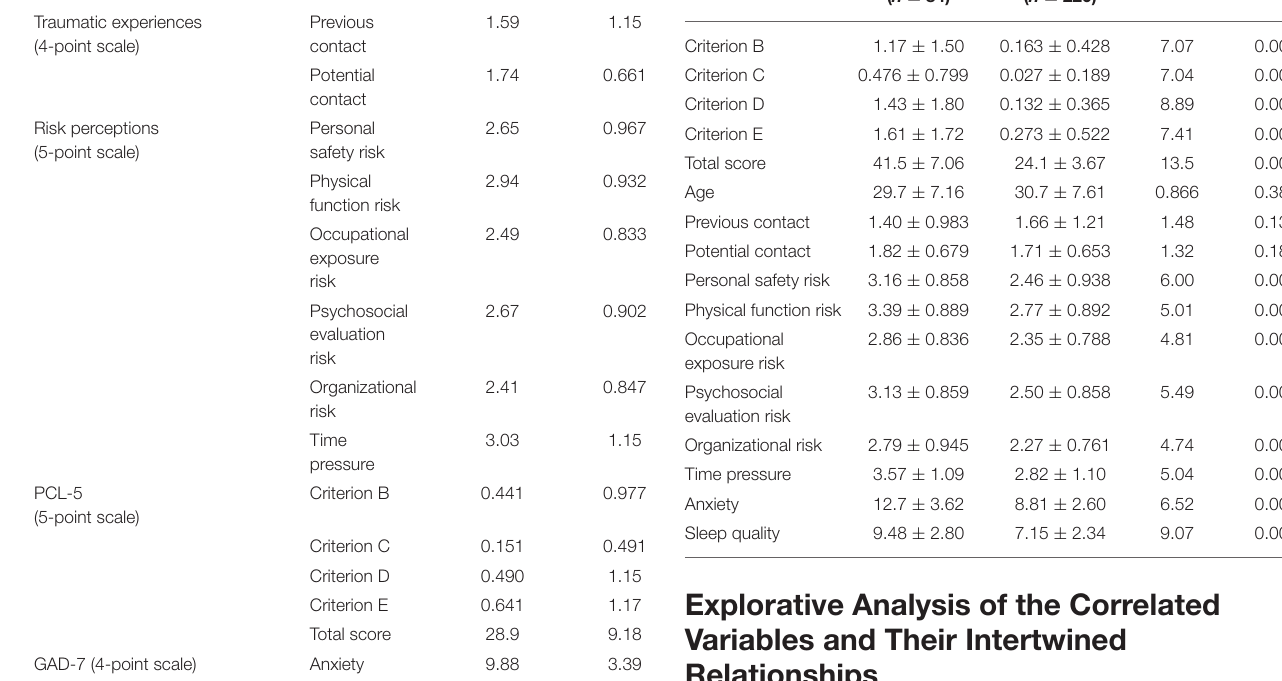
TABLE 1 | Means and standard errors for subscale and total scores of questionnaires. Questionnaires